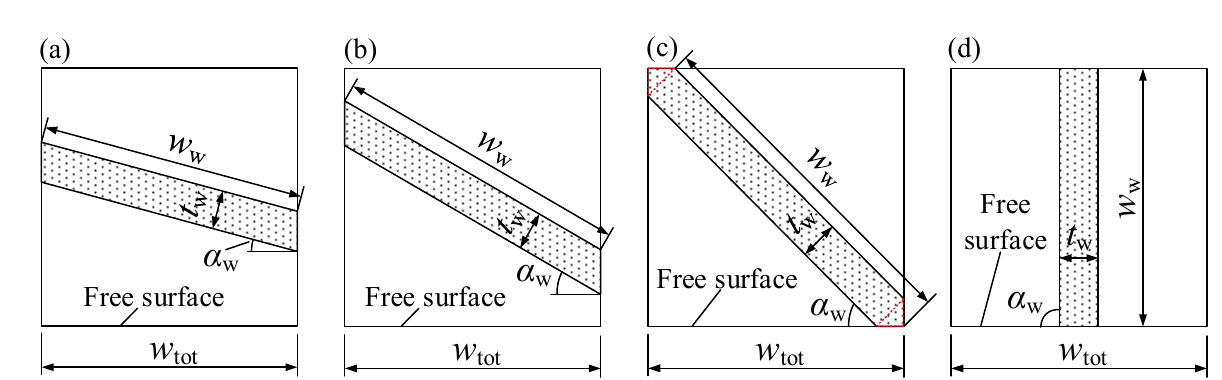
Figure 4. Distribution of weak interlayer with different dip angles ( a ) α w = 15°; ( b ) α w = 30°; ( c ) α w = 45° and ( d ) α w = 90°. Table 3. Three experimental cases and corresponding parameters. Case No.